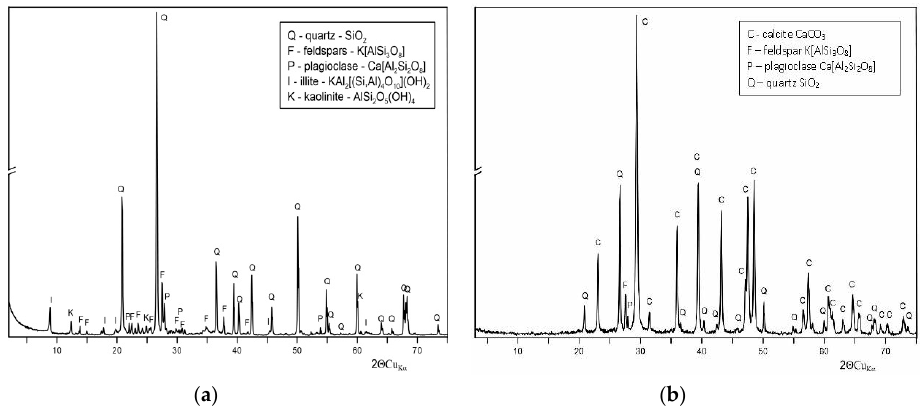
Figure 2. X-ray powder diffraction (XRD) analysis of ( a ) sandstone plate; ( b ) lime mortar. Samples of air for chemical compound and PM concentration analysis were collected in four time points of a summer touristic season (from April to October), as the majority of tourist traffic at the castle and at the bottom of the castle hill is recorded in this period. Environmental physico-chemical parameters specific for Rotunda are summarized in Tables 1 and 2. Table 1. Concentrations of selected compounds (mg/m 3 ) in the air of the Rotunda of Sts. Felix and Adauctus.